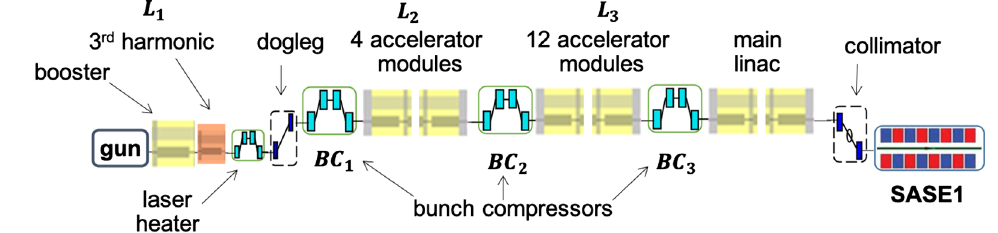
FIG. 1. Layout of the European XFEL with the SASE1 undulator line.